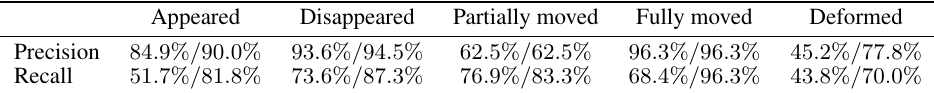
Table 2. Precision and recall for all change classes with and without considering segmentation